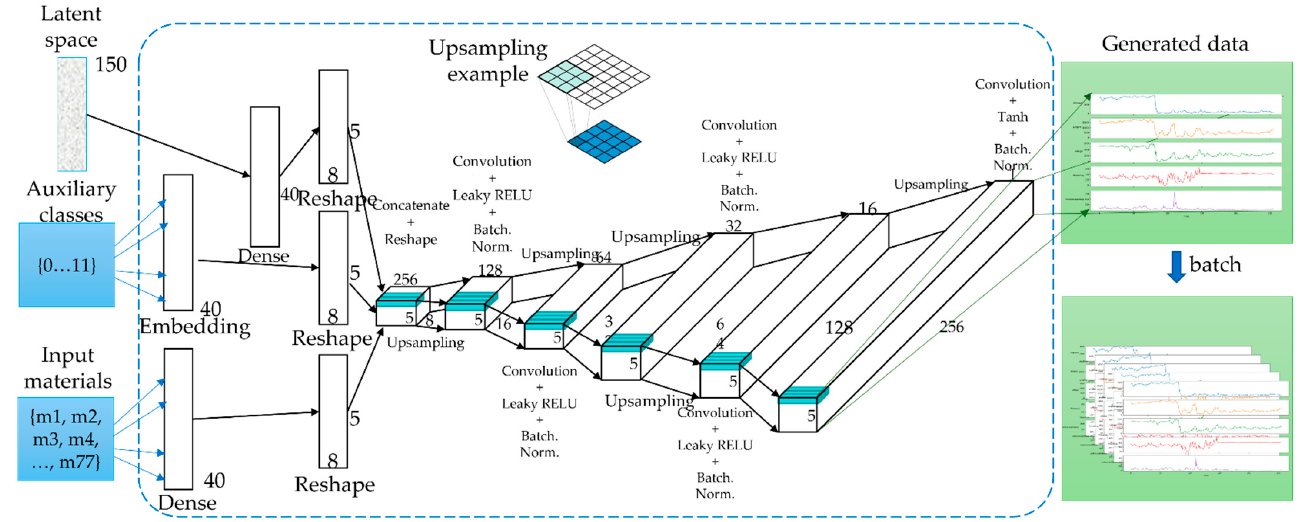
Figure A1. Implementation details of the generator model of AC ‐ GAN for the melting process.